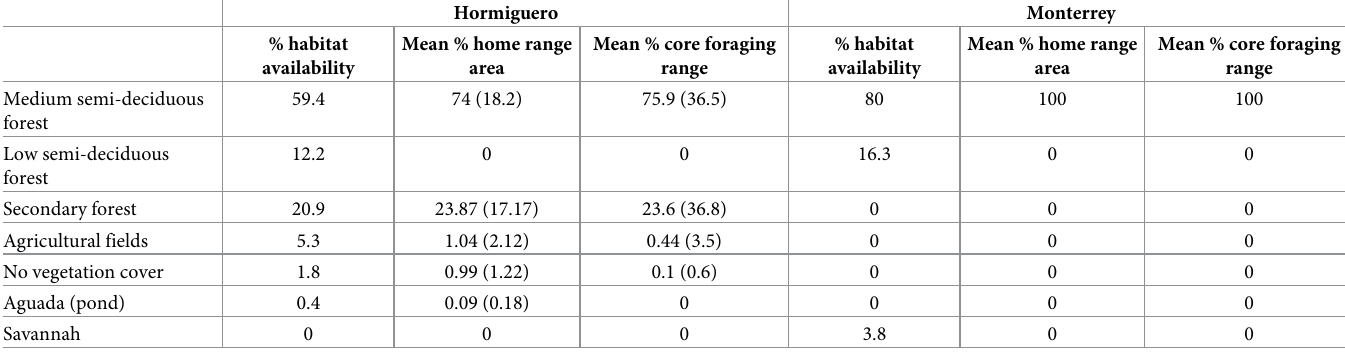
Table 3. Percentage of habitat availability assessed for Hormiguero and Monterrey and percentage (+ SD) of home range area and core foraging range within 100% minimum convex polygons (MCP) of Chrotopterus auritus tagged